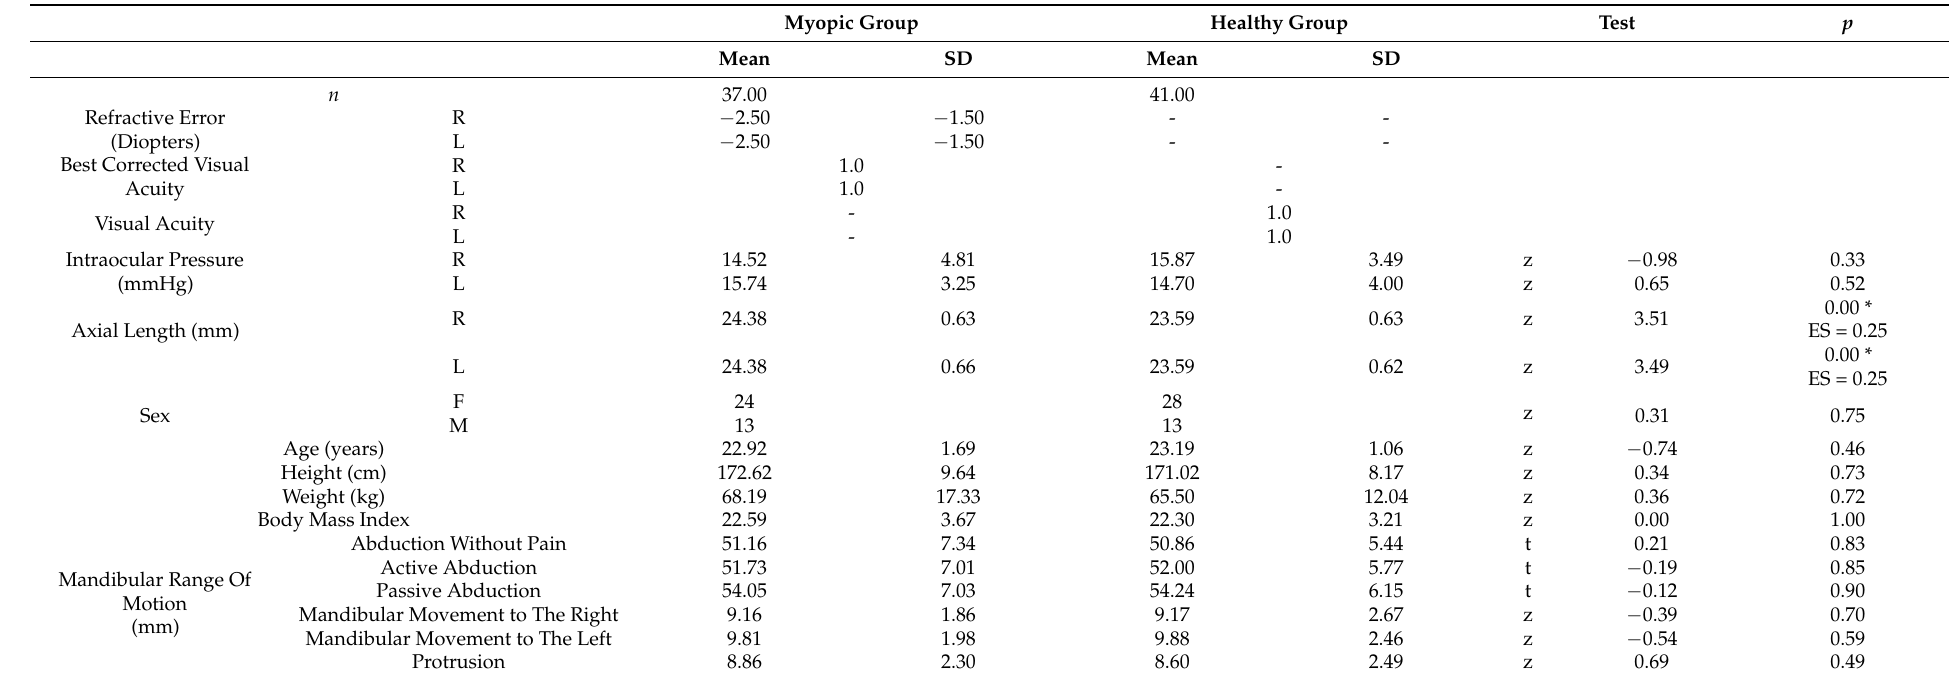
Table 1. Presentation of